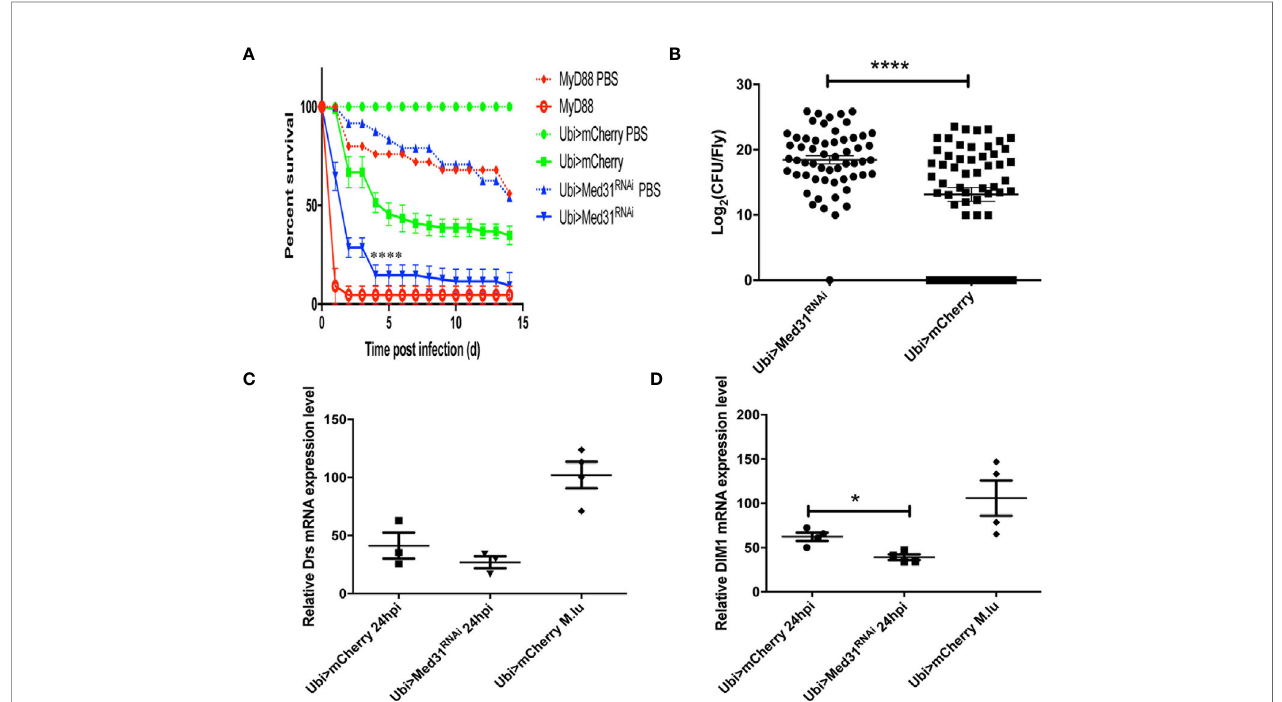
FIGURE 2 | Med31 RNAi fl ies are susceptible to E. faecalis infection. (A) Survival of Drosophila after E. faecalis infection. MyD88 was used as a positive control line (red), Ubi> mCherry RNAi line represented the wild type control line (green) and the Ubi > Med31 RNAi line survival is shown in blue. For each infected line a PBS- injected control was also performed (dotted lines). Med31 RNAi fl ies succumbed faster to infection than the wild type controls. Infected Med31 RNAi fl ies vs. infected mCherry RNAi fl ies: log-rank test, ****P < 0.0001. The survival curves are representative of nine independent experiments. (B) Bacterial load in the hemolymph after 24 h of infection. Each dot represents the burden of a single fl y. The bacterial load in the Med31 RNAi fl ies was higher than the controls at 24 h post infection. ***P < 0.001. (C, D) Expression level of Drosomycin (C) and DIM1 (D) normalized to the Rpl32 house keeping gene 48 h post infection. Each dot represents one sample containing four fl ies. Septic infection with M. luteus was a positive control for Drosomycin and DIM1 expression. Drosomycin expression level in Med31 RNAi fl ies was not signi fi cantly different from control fl ies (C) but DIM1 expression level was signi fi cantly decreased at 24 h post infection. *P < 0.05. Mean ± SEM are indicated (B – D)